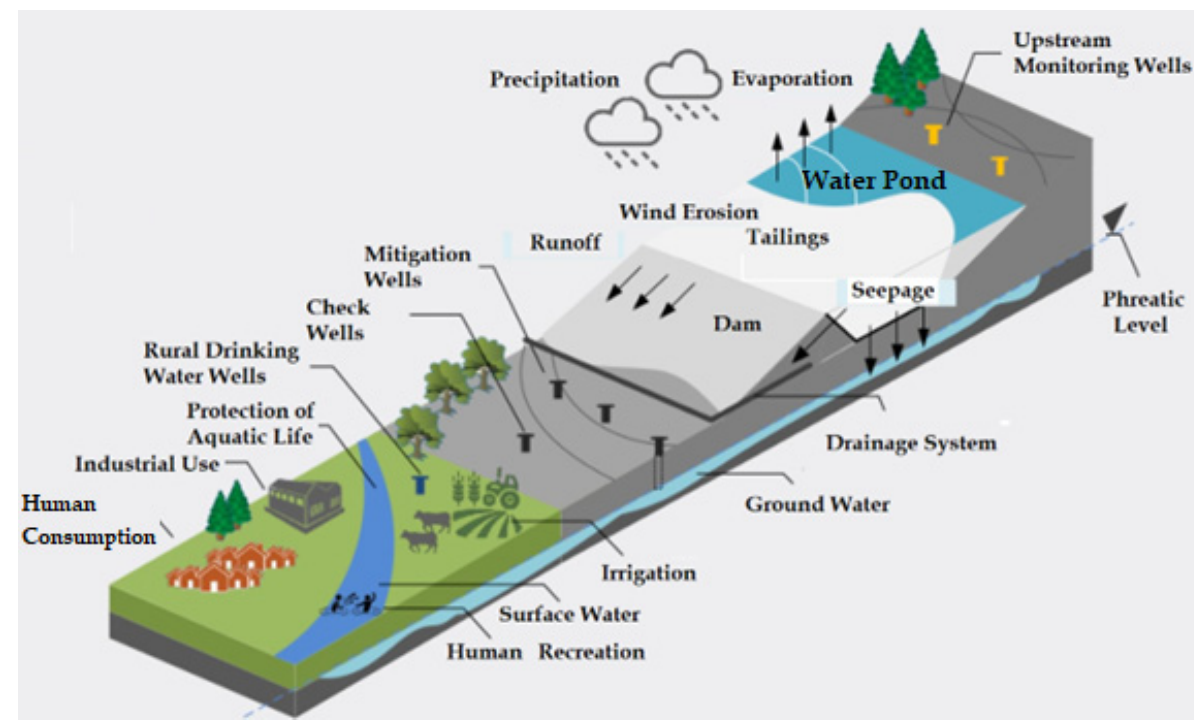
Figure 1. Schematic view of process water (water in contact with mine tailings) management and seepage control in TSF.